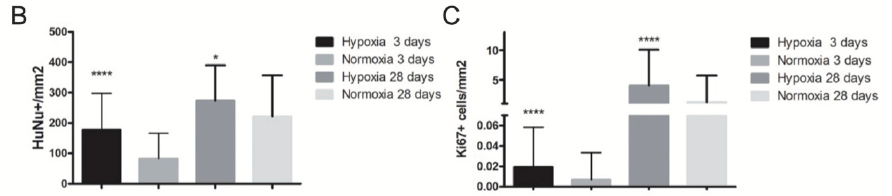
Figure 6. In vivo human cell engraftment and proliferation. ( A ) Representative images of implanted construct cultured in hypoxia or normoxia culture. Immunofluorescence staining for specific human nuclei antibody HuNu (green) and for the proliferation marker Ki67 (red) at time points 3 and 28 days (d). Cell nuclei were stained by DAPI (blue). Scale bar = 40 µm. ( B ) Quantification of total number of implanted human cells (double positive for HuNu and DAPI) and ( C ) proliferation cells (triple positive for HuNu, Ki67 and DAPI) following 3 and 28 days in vivo implantation. * p < 0.01, **** p < 0.00001. Number of donors: 3 (at least duplicate biological samples per donor). Comparison was performed with one ‐ way ANOVA.